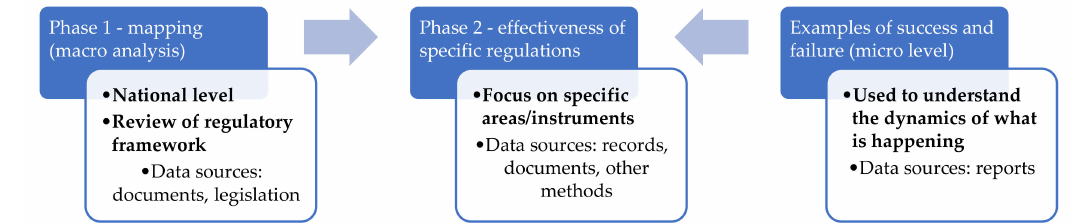
Figure 1. Conceptual